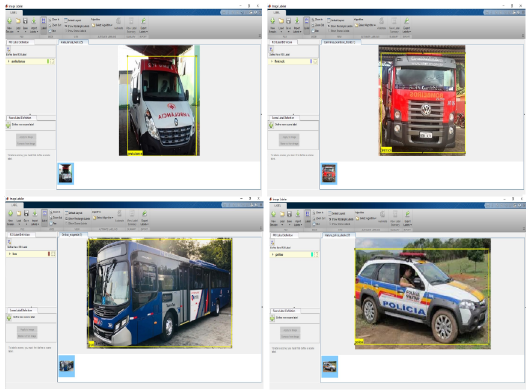
Figure 5. Images of the database created with standard Brazilian